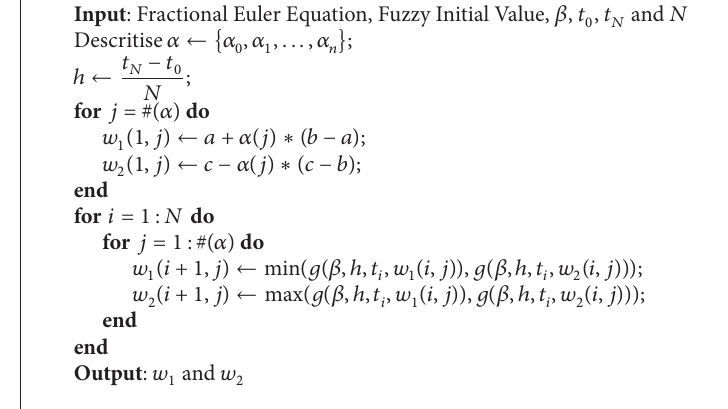
Algorithm 1: Fuzzy fractional Euler method for a linear